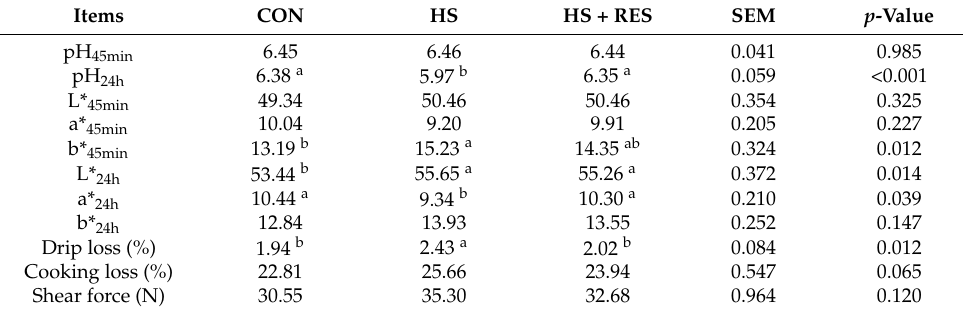
Table 3. Effects of RES on the meat quality of heat-stressed broilers.